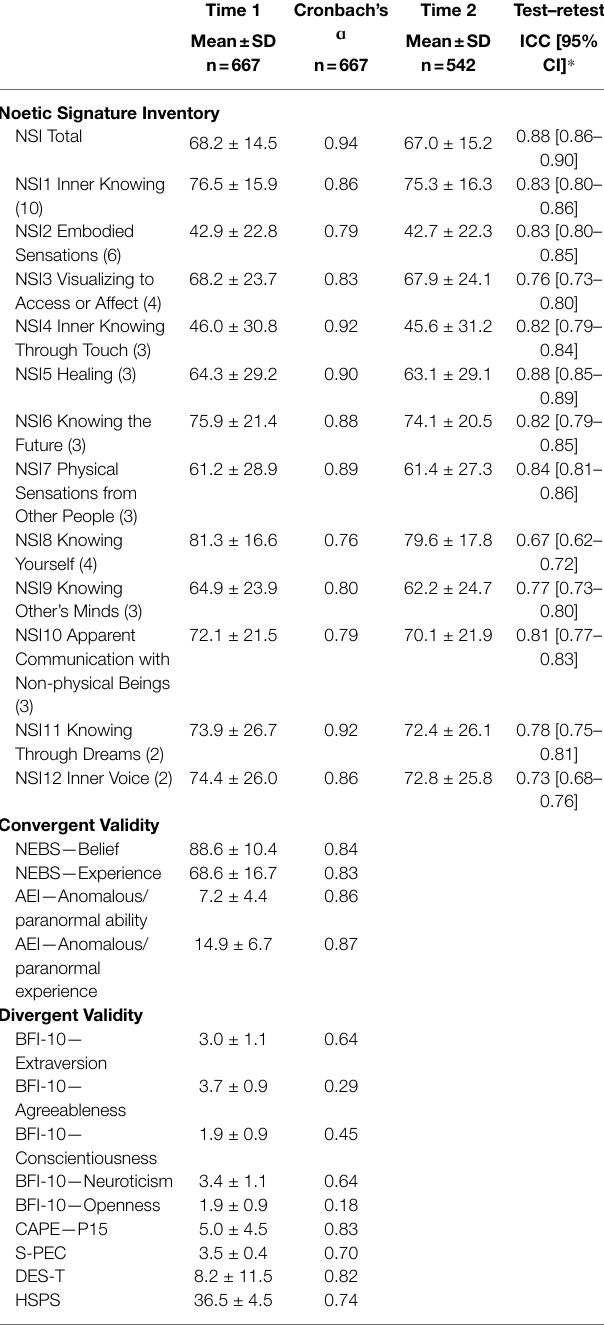
TABLE 1 | Mean values, standard deviations, and Cronbach’s alphas for